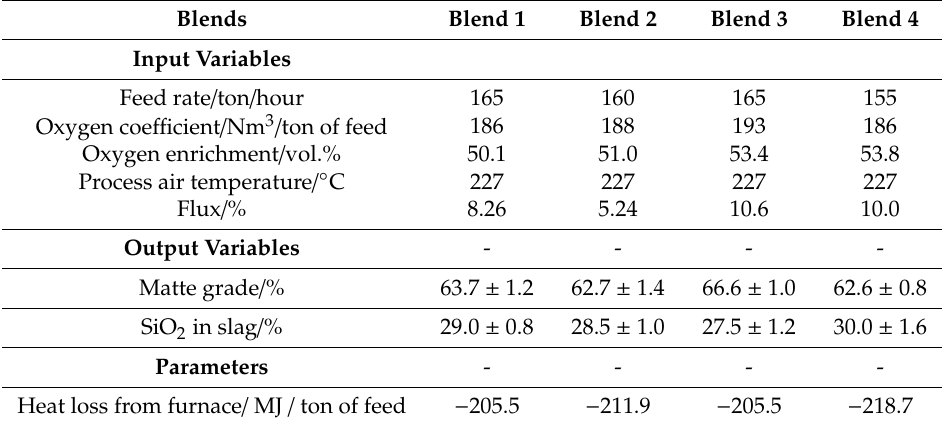
Table 13. Operational data sets and results related to smelted blends.